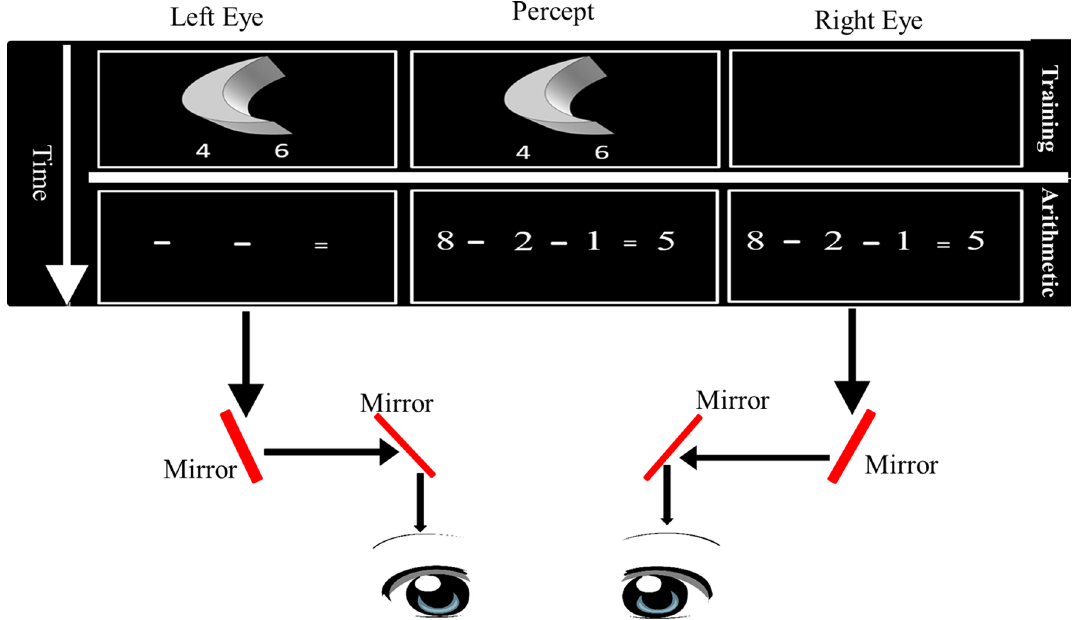
Figure 1. Schematic illustration of the experimental apparatus. The visual information passes from the screen monitor—through the eyes—to the brain. Each side of the computer monitor provided visual information to a different eye. From the eye, the visual information passes first through monocularly segregated subcortical regions. This information is then projected to the lateral geniculate nucleus (LGN) and subsequently reaches striate and binocular extrastriate